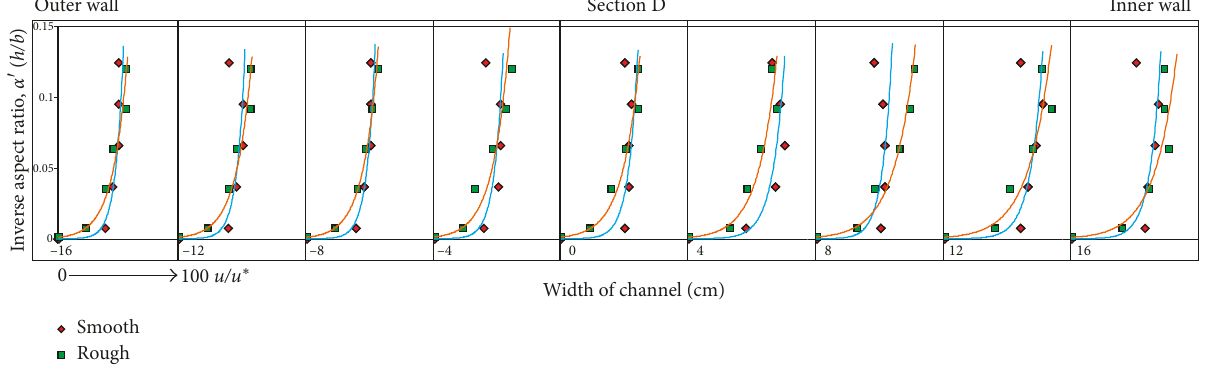
Figure 7: Comparison of velocity variation in section D.